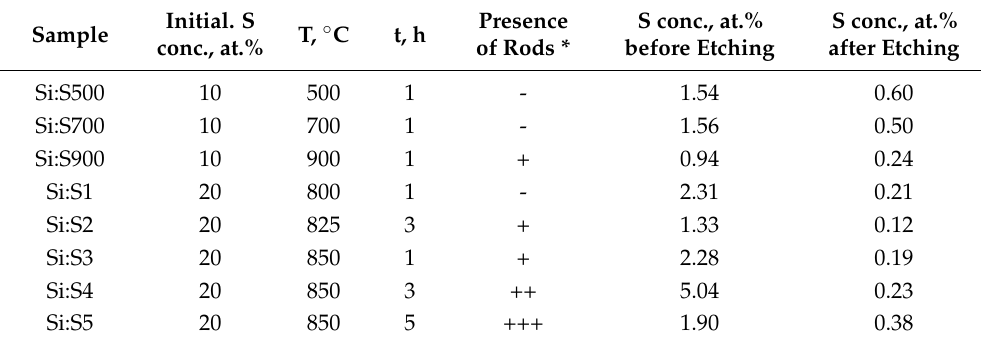
Table 1. Annealing conditions, impurity content and qualitative frequency of rod-like object observa- tions for samples treated with sulfur.